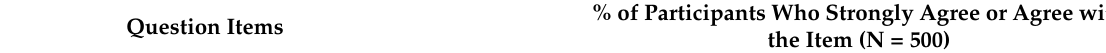
Table 4. List of question items under “trust in project” composite measure. All items are measured on a 5-point Likert scale (1 = strongly disagree, 5 = strongly agree).